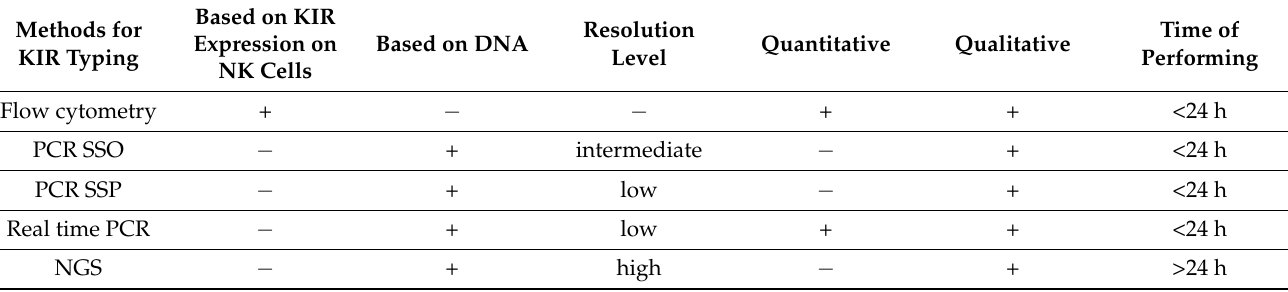
Table 1. Methods for KIR